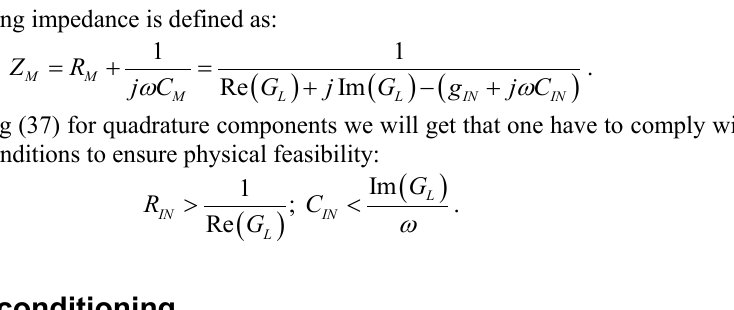
Fig. 3. Modulating capacitance against amplitude and phase of the reflection